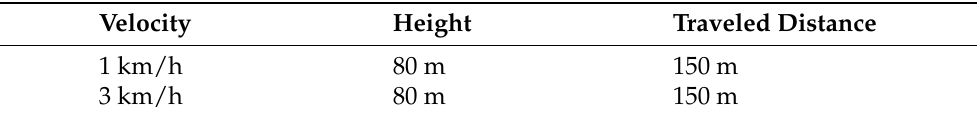
Table 5. Scenario 3